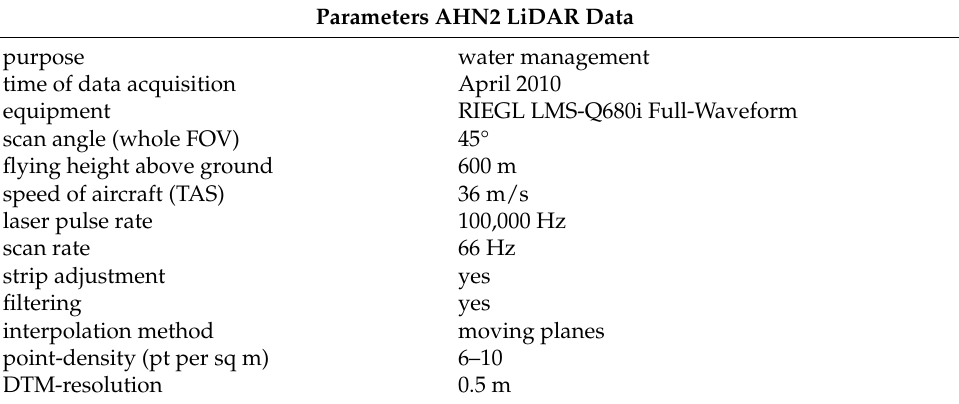
Table 1. The parameters of the LiDAR data used in this research, after Ref. [35].